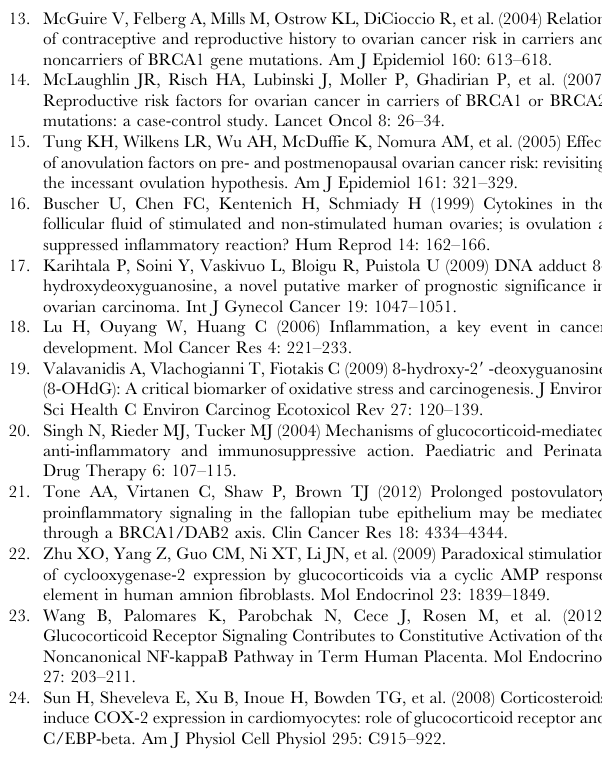
Table S1 Annotation of Genes in Venn diagram shown in Figure 2. (XLSX) File S1 Supporting Figures. Figure S1. Network Module 0, representing ‘Inflammatory response, Interleukin signaling and NF k B signaling’ shown in Figure 3. Figure S2. Network Module 1, representing ‘Chromosomal maintenance and Cell cycle’ shown in Figure 3. Figure S3. Network Module 2, representing ‘Integrin signaling and Extracellular matrix organization’ shown in Figure 3. Figure S4. Network Module 3, representing ‘Ubiquitin mediated proteolysis and Antigen processing and presentation’ shown in Figure 3. Figure S5. Network Module 4, representing ‘G protein coupled receptor signaling and downstream targets’ shown in Figure 3.